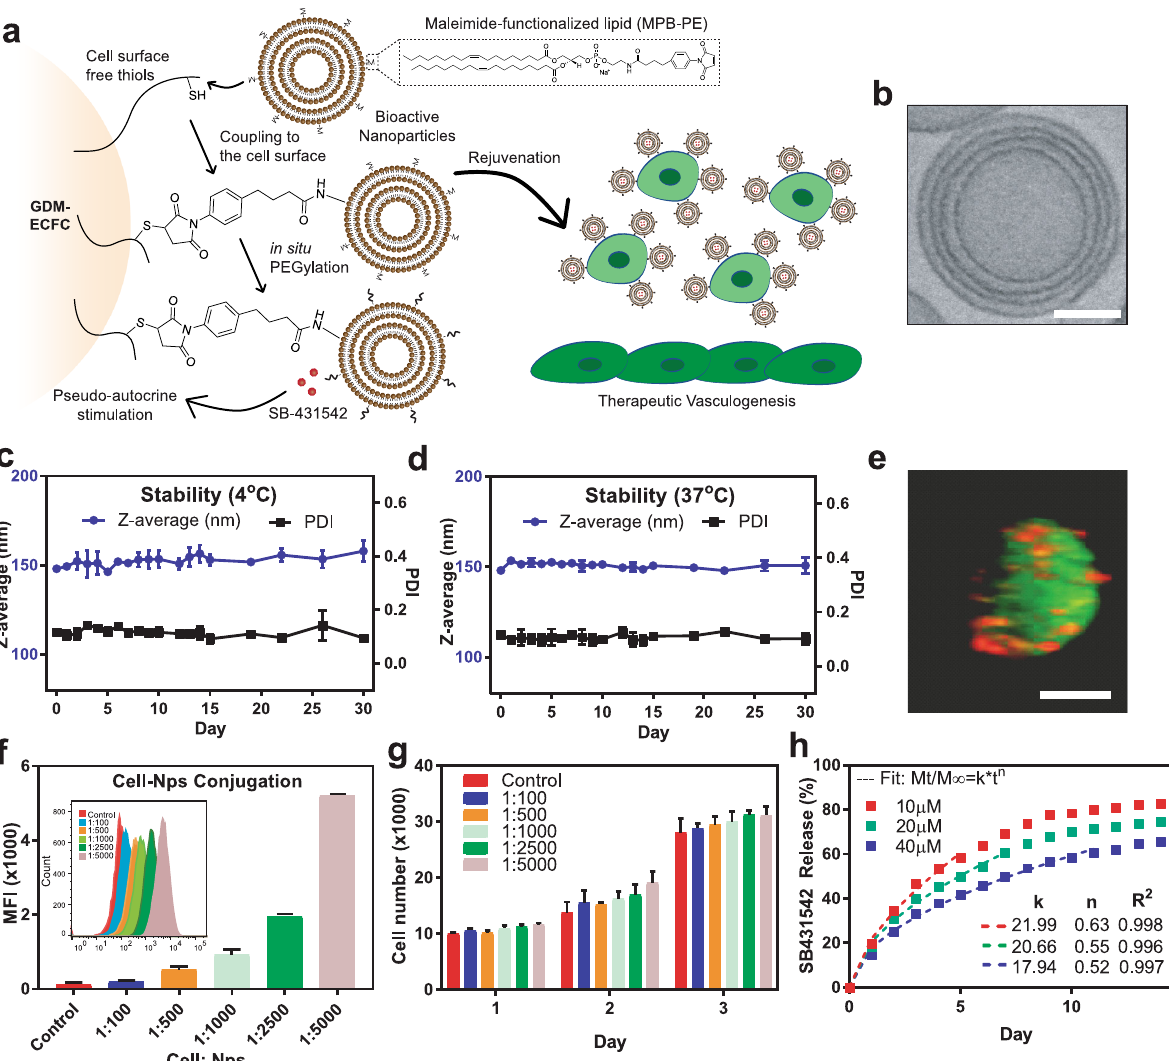
Fig. 1 Synthesis and characterization of bioactive nanoparticles. a Schematic of maleimide-based conjugation of bioactive nanoparticles to the ECFC surface ’ s free thiols followed by in situ PEGylation. Continuous pseudo-autocrine stimulation of GDM-ECFCs with SB-431542 improves their clinical potential for therapeutic vasculogenesis. b A CryoTEM photograph demonstrating the multilamellar structure of the nanoparticle. Scale bar is 50nm. c , d The stability of the nanoparticles was quanti fi ed using DLS for hydrodynamic diameter (z-average) and polydispersity (PDI) over 30 days in buffer at ( c ) 4 °C and ( d ) 37°C (physiological temperature). The data represent the mean ± s.d. of three independent experiments conducted in triplicate. e A confocal photograph demonstrating a stable conjugation of Dil-labeled multilamellar lipid nanoparticles (red) conjugated onto the surface of a CFSE-labeled ECFC (green). Scale bar is 10 µ m. f Flow cytometry analysis demonstrated an increase in mean fl uorescence intensity (MFI) when the ratio of cell to nanoparticles was increased from 1:100 to 1:5,000. Inset indicates the corresponding histogram data. g The viability of ECFCs with various cell to nanoparticle ratios (1:100 to 1:5,000) was quanti fi ed using alamar blue assay over three days. No signi fi cant difference was observed between non-conjugated cells and nanoparticle-conjugated cells (mean± S.D., three independent experiments conducted in triplicate). h Accumulative release of the bioactive small molecule, SB-431542 (SB), from the NPs over 2 weeks. Three different initial concentrations of SB (10, 20, 40 µ M) were encapsulated into the NPs and the amounts of SB released were measured daily. The release pro fi les were fi t for Korsmeyer-Peppas equation and the fi tting parameters are shown within the